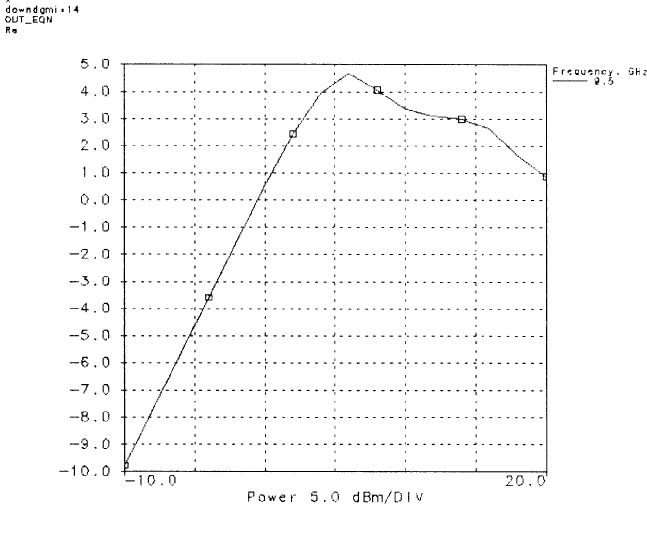
FIGURE 10 Conversion gain vs. the power of the LO